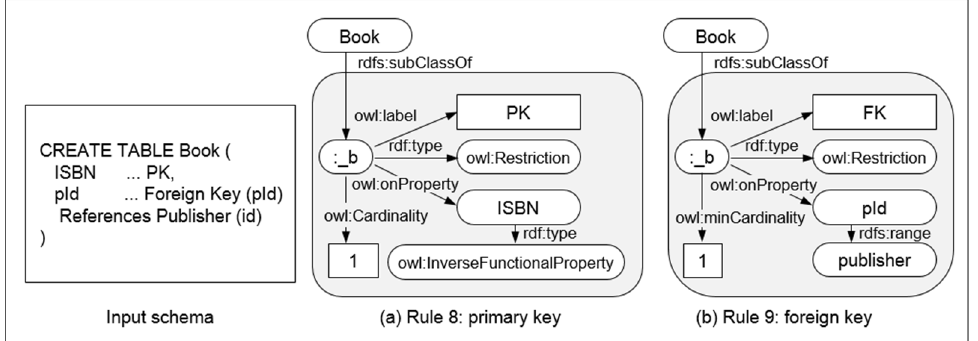
Figure 16. Examples of mapping integrity constraints (Rule 8,9).